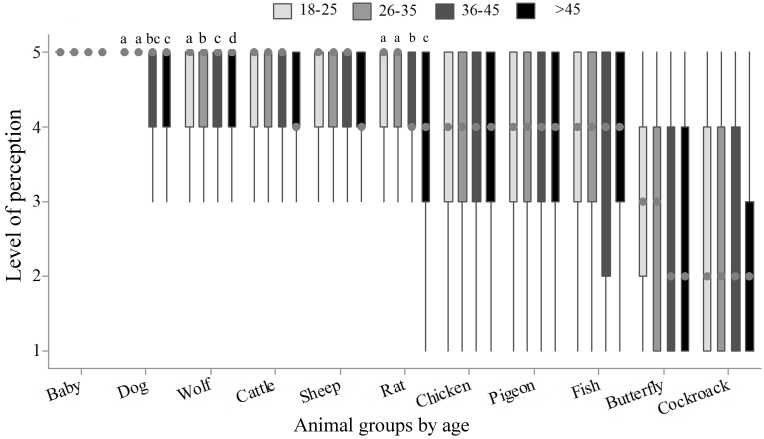
Perception of animal sentience (Q2) data for age, by 782 citizens of Bogotá and Curitiba, 2014/2015.1 = no sentience and 5 = maximum sentience; letters indicate differences between age groups (P<0.05, Kruskal-Wallis and Dunn Test).